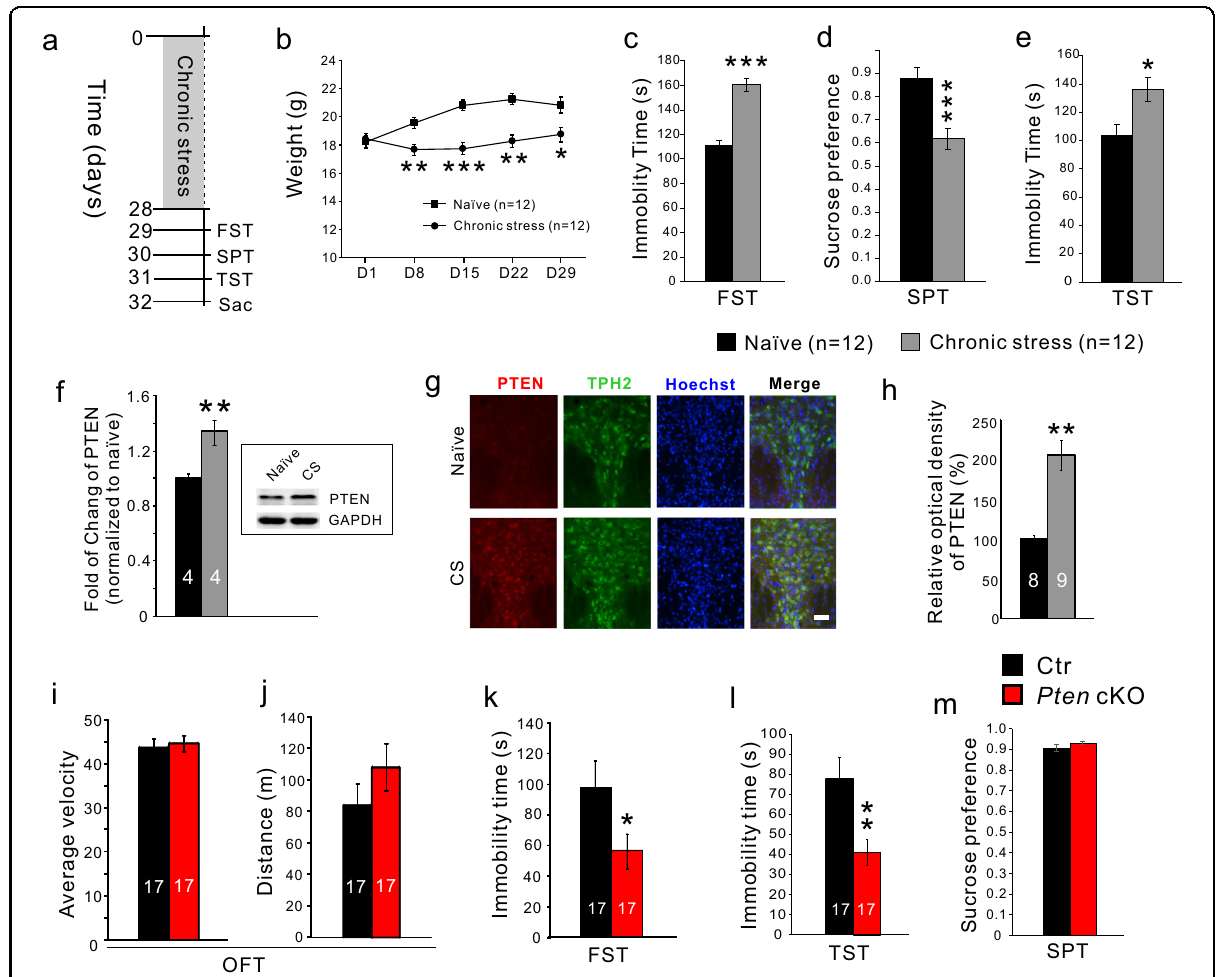
Fig. 1 Chronic stress increased PTEN expression in 5-HT neurons and speci fi c knockout of Pten in 5-HT neurons induced lower depression- like behavior in mice. a Experimental design of chronic stress. Mice were sacri fi ced (Sac) 1 day after behavioral tests. FST, force swimming test; SPT, sucrose preference test, TST tail suspension test. b Increase in body weight is prevented during 4-week chronic restraint. c . Immobility time in FST is increased in mice with the 4-week treatment relative to controls. d SPT shows a reduction of the preference in mice with the 4-week treatment. e Immobility time in TST is increased in mice with the 4-week treatment relative to controls. f Western blot shows the elevation of PTEN in midbrain tissues of chronic stress-treated mice. g Immunostaining shows the elevation of PTEN in 5-HT neurons in the dorsal raphe nucleus of mice treated with chronic stress (CS). Scale bar = 100 μ m. h Comparison of PTEN immuno fl uorescence density in 5-HT neurons. i , j Average velocity and ambulatory distance in open fi eld tests are comparable between control and Pten cKO mice. OFT, open fi eld test. k, l Immobility time is reduced in the force swimming test and tail suspension test in Pten cKO mice compared with controls. m SPT shows no difference between control and Pten cKO